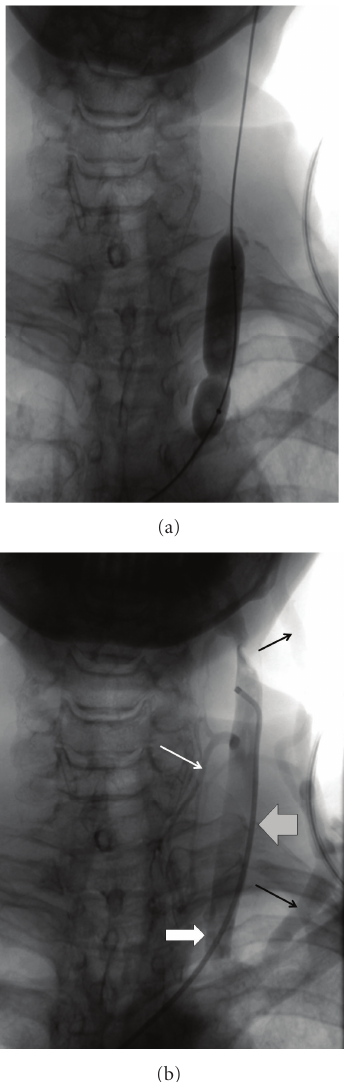
Figure 1: (a) Balloon angioplasty of the left internal jugular valve; impression on the balloon indicates the location of restricting annulus. (b) Post-balloon venography of the left internal jugular vein: satisfactory outflow from the vein; stenosis that was previously seen during angioplasty (thick white arrow) disappeared, there is, however, still collateral outflow through the external jugular vein (thin black arrows) and the thyroid veins (thin white arrow); thick grey arrow points the area of compression by omohyoid muscle (revealed by means of sonography at followup): this compression does not show up at venography.